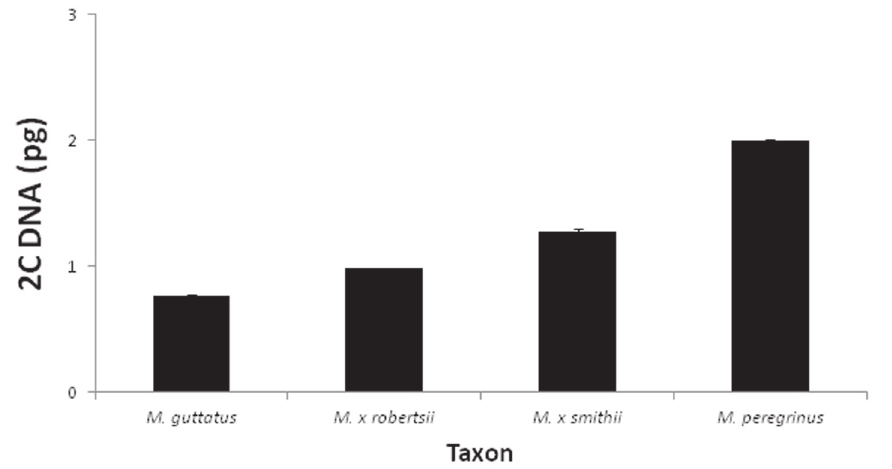
Figure 3. Flow-cytometry estimates of 2C DNA content (DAPI-stained) of British Mimulus . Error bars represent standard errors when multiple individuals per taxon were tested. Sample sizes as follows (chromosome numbers for each population are given in parenthesis when available). M. guttatus : N = 4 individuals from Dunblane, Perthshire (2n = 28); and 2 individuals from Muckle Roe, Shetland; M. × robertsii (= M. guttatus × M. luteus ): N = 1 individual from Nenthall, Cumbria (2n = 44, 45); M. × smithii ( = M. luteus var. luteus × M. luteus var. variegatus ): N = 2 individuals from Coldstream, Scottish Borders (2n = 59, 60, 61, 62); M. peregrinus: N = 6 individuals from Leadhills, South Lanarkshire (2n = 92). All chromosome counts kindly provided by J.